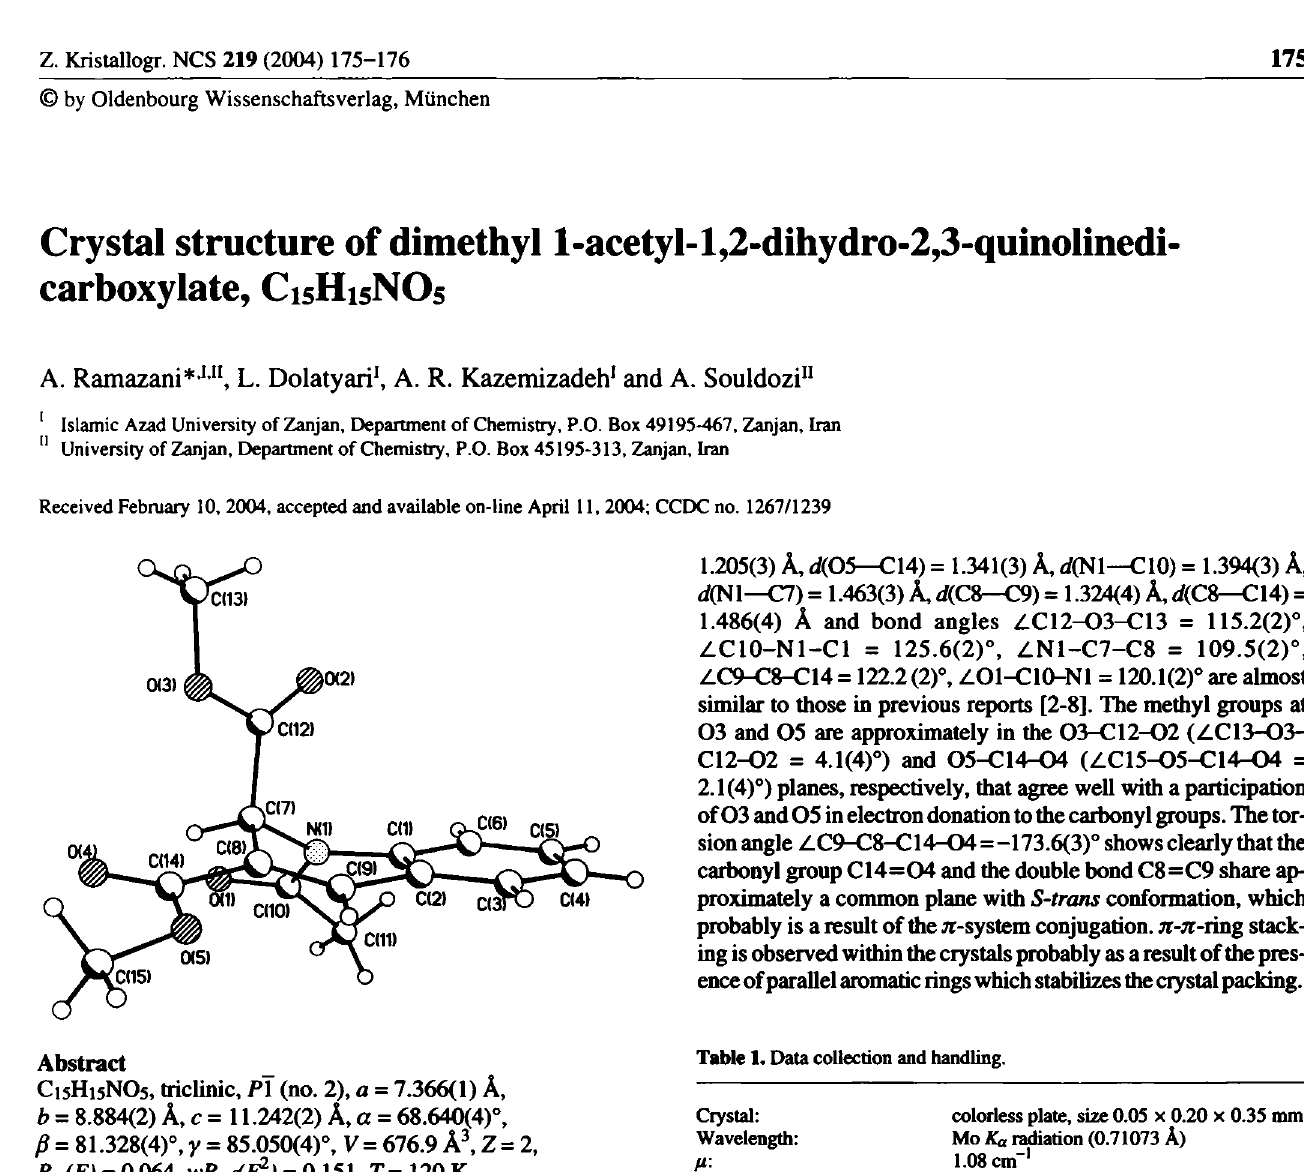
Table 2. Atomic coordinates and displacement parameters (in Â 2